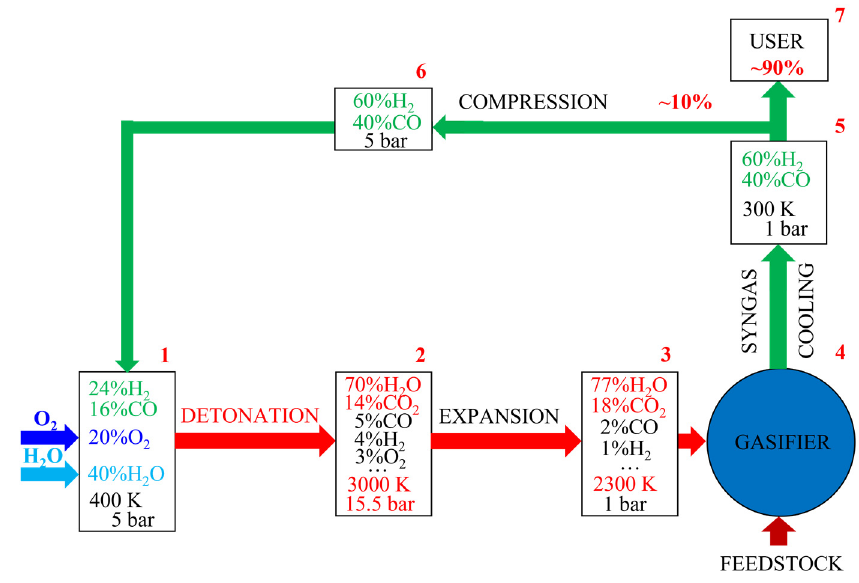
Figure 3. Flow chart of waste gasification by ultra-superheated steam.